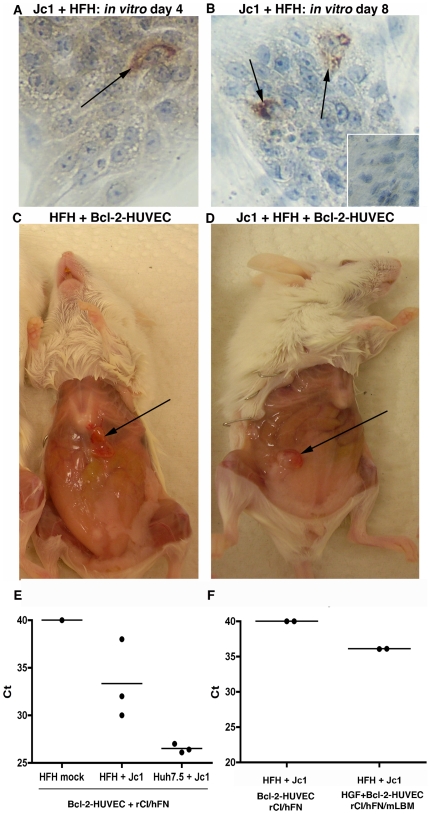

In vitro and in vivo maintenance of HCV Jc1 infection in HFH.A, B: IHC staining for HCV NS5A revealed rare positive HFH at day 4 and day 8 post-infection (arrows in A and B, respectively). Similarly stained mock-infected HFH cultures confirmed the specificity of the HCV NS5A IHC assay (B, inset). C, D: Mock- or HCV Jc1-infected HFH cells were co-engrafted with Bcl-2-HUVEC and a rCI/hFN matrix on the abdominal wall of SCID/bg mice (C and D, respectively). Representative gels harvested at 2 weeks post-engraftment are highlighted by black arrows. E, F: qRT-PCR analysis revealed the presence of HCV RNA in Jc1-infected HFH gels (E, middle column), but not in mock-infected gels (E, left column). Analysis of mRNA extracted from HCV Jc1-infected Huh-7.5-containing gel tissue was used as a positive control (E, right column). Increased levels of HCV Jc1 RNA were detected in gels containing additional HGF-HUVEC and mLBM, compared to the Bcl-2-HUVEC and rCI/hFN gel system (F, right versus left column, respectively). Data points represent individual gels.